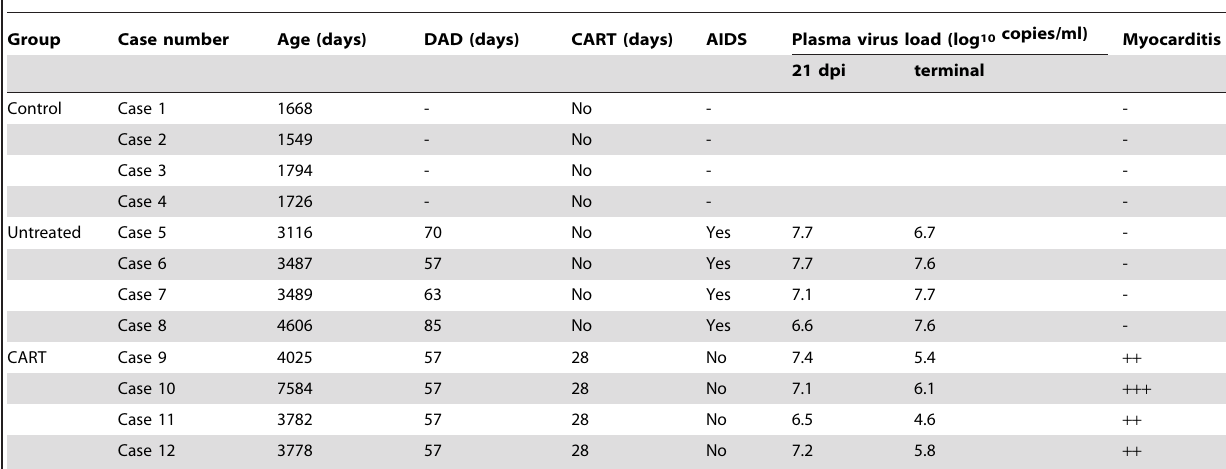
Table 1. Animals and